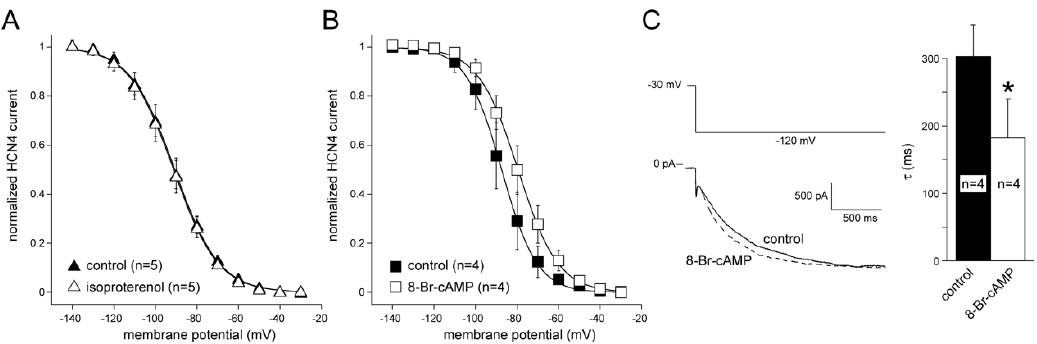
Figure 4. I f modulation in CMPCs expressing HCN4-GFP. ( A ) Effects of 10 nM Isoproterenol on voltage dependency of I f activation. ( B ) Effects of 1 mM 8-Br-cAMP on voltage dependency of I f activation and speed of I f activation at −120 mV. ( C ) typical I f traces at –120 mV in the absence and presence of 8-Br-cAMP. * indicates P < 0.05.